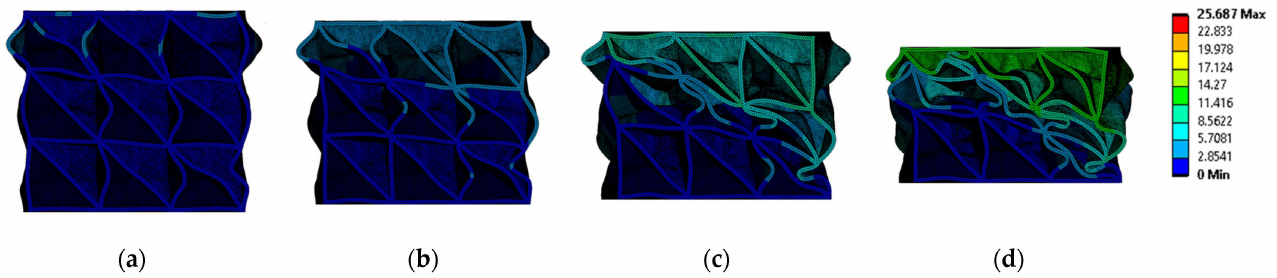
Figure 12. ( a – d ) Deformation stages of compression of the regular-scale, novel honeycomb sample under lateral load, reproduced via FE Analysis by observing the deformation mechanism of the experimental tests (Figure